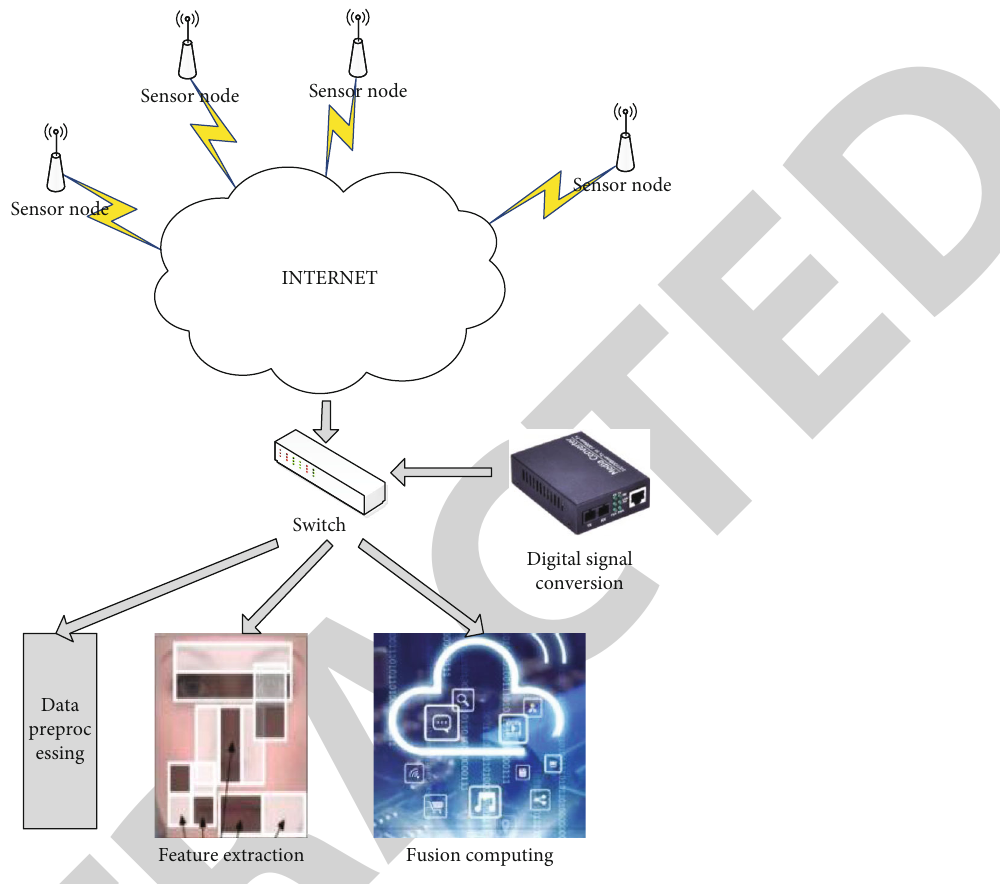
Figure 2: Multisource data fusion